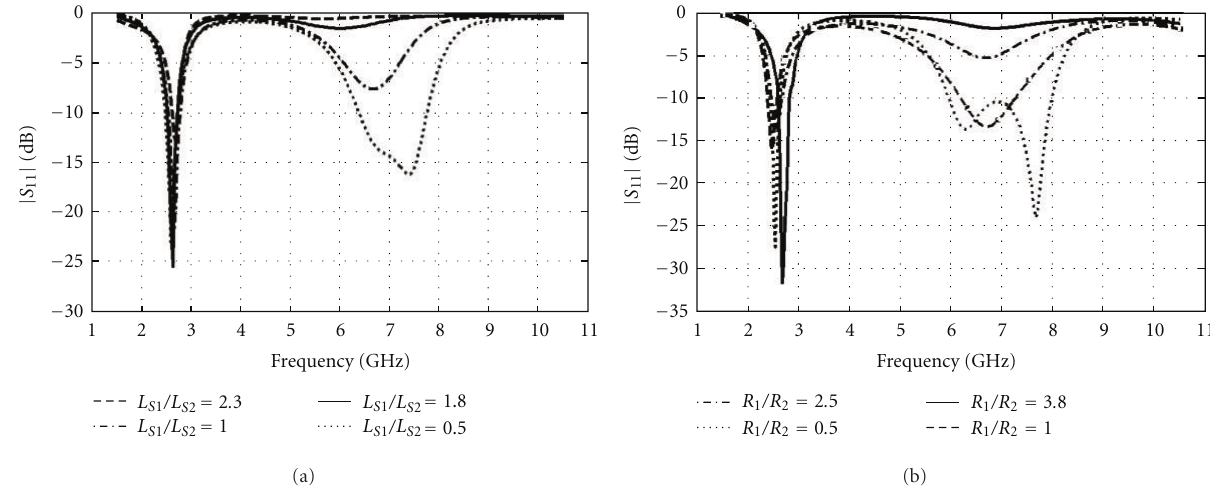
Figure 7: Simulated reflection coe ffi cients of (a) RDGS slot antenna versus ratios of L S 1 /L S 2 and (b) CDGS slot antenna versus ratios of R R 1 / 2 . The other parameters are constant and seen in Figure 1.